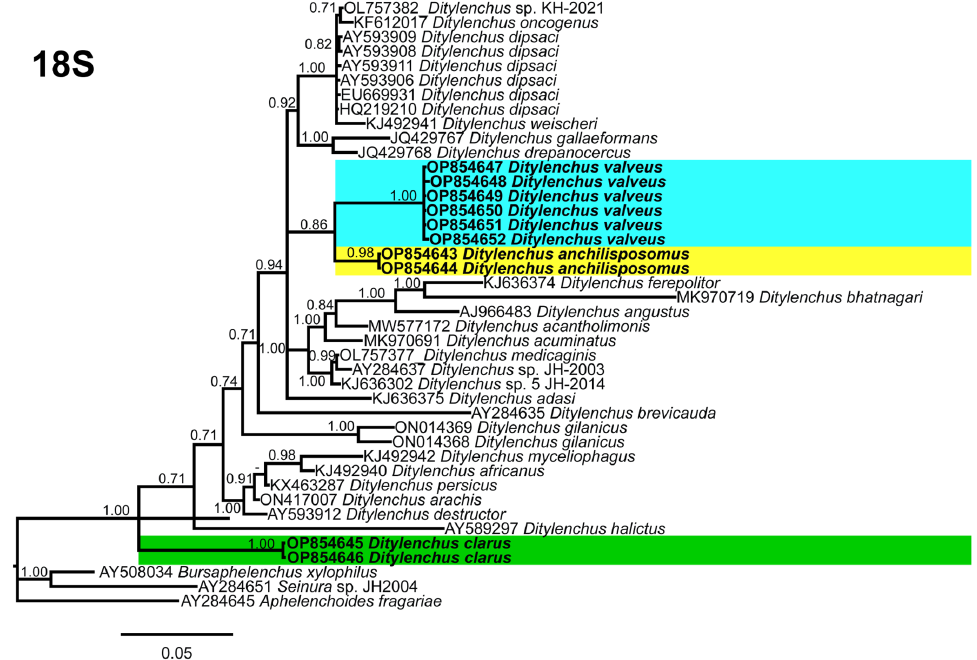
Figure 8. Phylogenetic relationships of the Canadian population of Ditylenchus species with related species. Bayesian 50% majority rule consensus tree as inferred from 18S rRNA sequence alignment under the general time − reversible model with invariable sites and a gamma − shaped distribution (GTR + G + I). Posterior probabilities of greater than 0.70 are provided for the corresponding appro- priate clades. The sequences produced in this study are shown in bold, and the colored boxes indicate the clade association of the recovered Ditylenchus species.